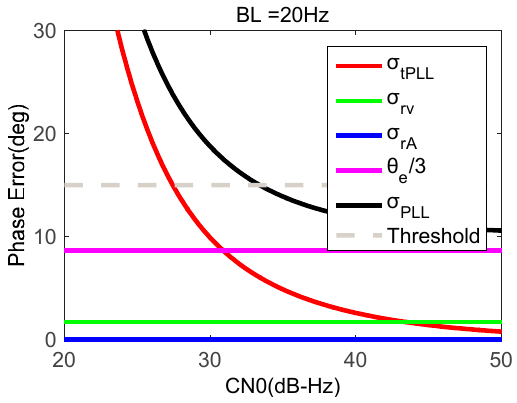
Figure 5. Phase errors of second-order PLL as a function of signal strength.